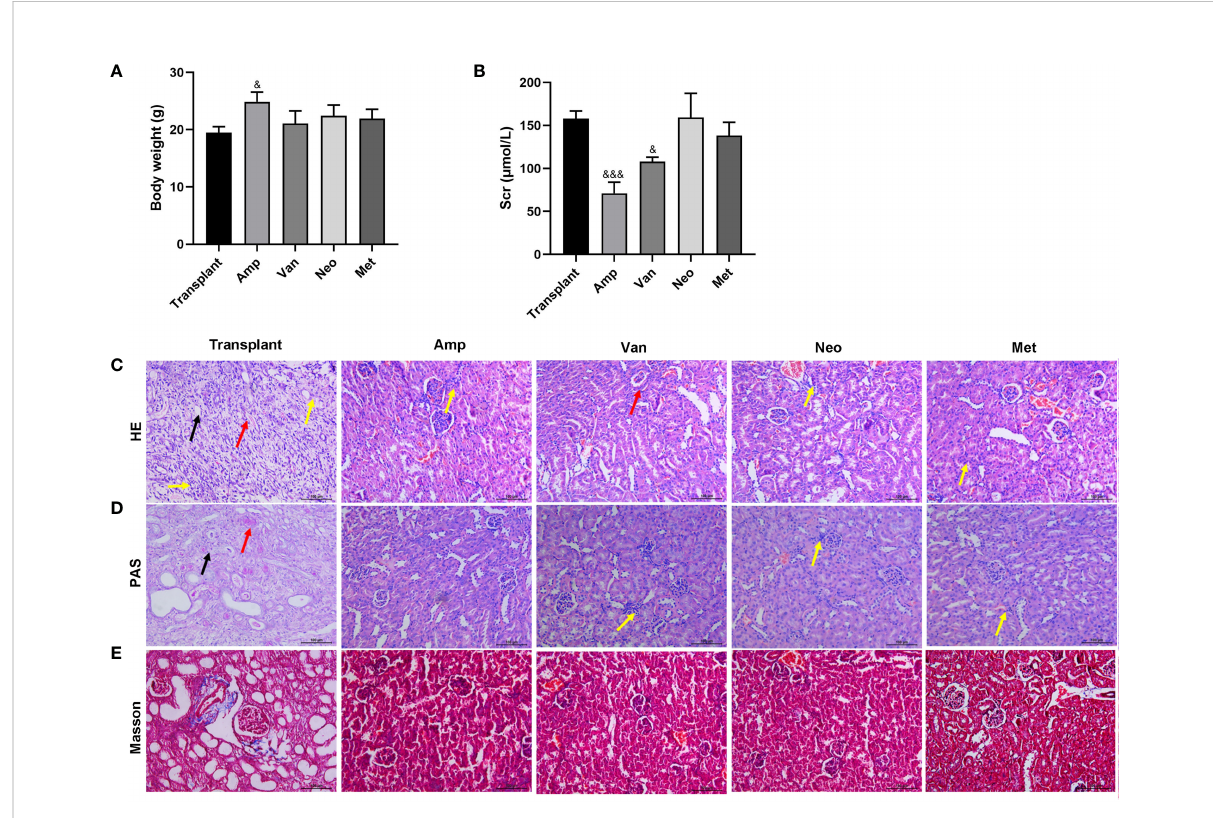
FIGURE 3 Effect of single antibiotic on renal transplantation in mice. Balb/c mice were treated with antibiotics ampicillin (Amp), vancomycin (Van), neomycin sulfate (Neo), and metronidazole (Met), respectively, and then underwent renal transplantation. (A) Compare the body weight of mice in each group. (B) The serum creatinine level. (C-E) HE, PAS and Masson staining were used to pathological examination of the transplanted renal. The yellow arrow indicates diffuse in fl ammatory cell in fi ltration, the black arrow indicates tubular necrosis, and the red arrow indicates tubulitis. & p < 0.05, &&& p < 0.001 vs transplant